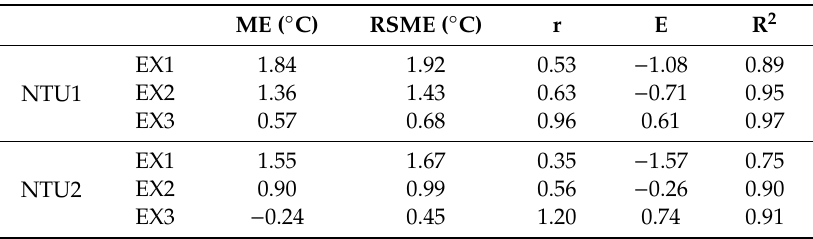
Figure 7. Comparisons between the model data and the NTU2 data. a : Wind speed and pressure. b : Upper 25 m-averaged temperature, the time axis indicates the model output time. c : Temperature profiles at the corresponding moment ticked in b. Table 3. Comparisons of the T 25m between the buoy observations and numerical experiments during the TC.